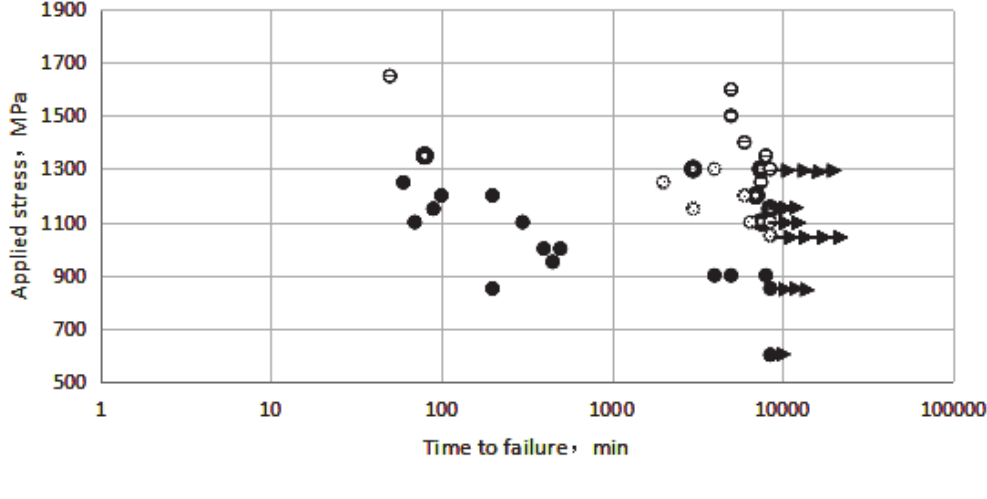
Figure 3: Curves for stress – time of failure of the experimental materials in different states in notched tensile experiment.